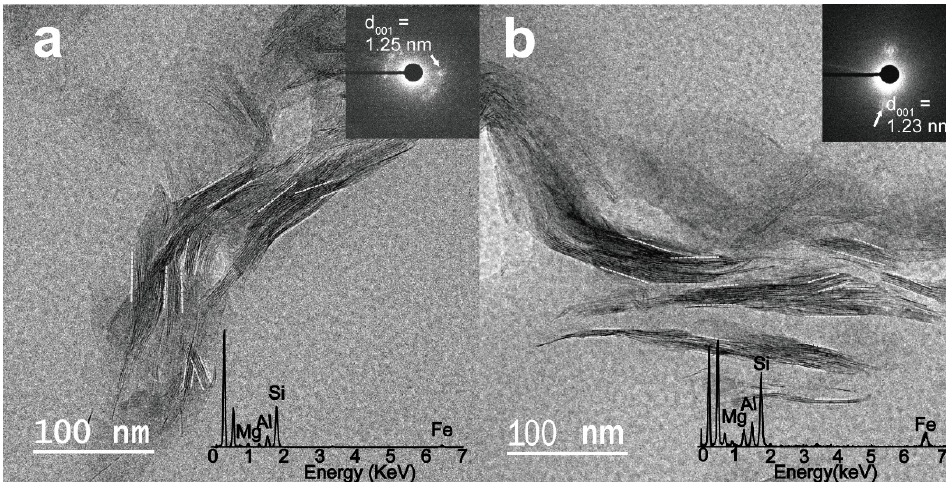
Figure 6. Representative TEM micrographs of lattice fringes of smectites in sediments from ( a ) the last glacial period (with an inset figure of the SAED pattern of smectite (d 001 = 1.25 nm)), and ( b ) the present interglacial period (with an inset figure of the SAED pattern of smectite (d 001 = 1.23 nm)) in cores from GC360. The elemental composition of smectite was measured using TEM-EDS.